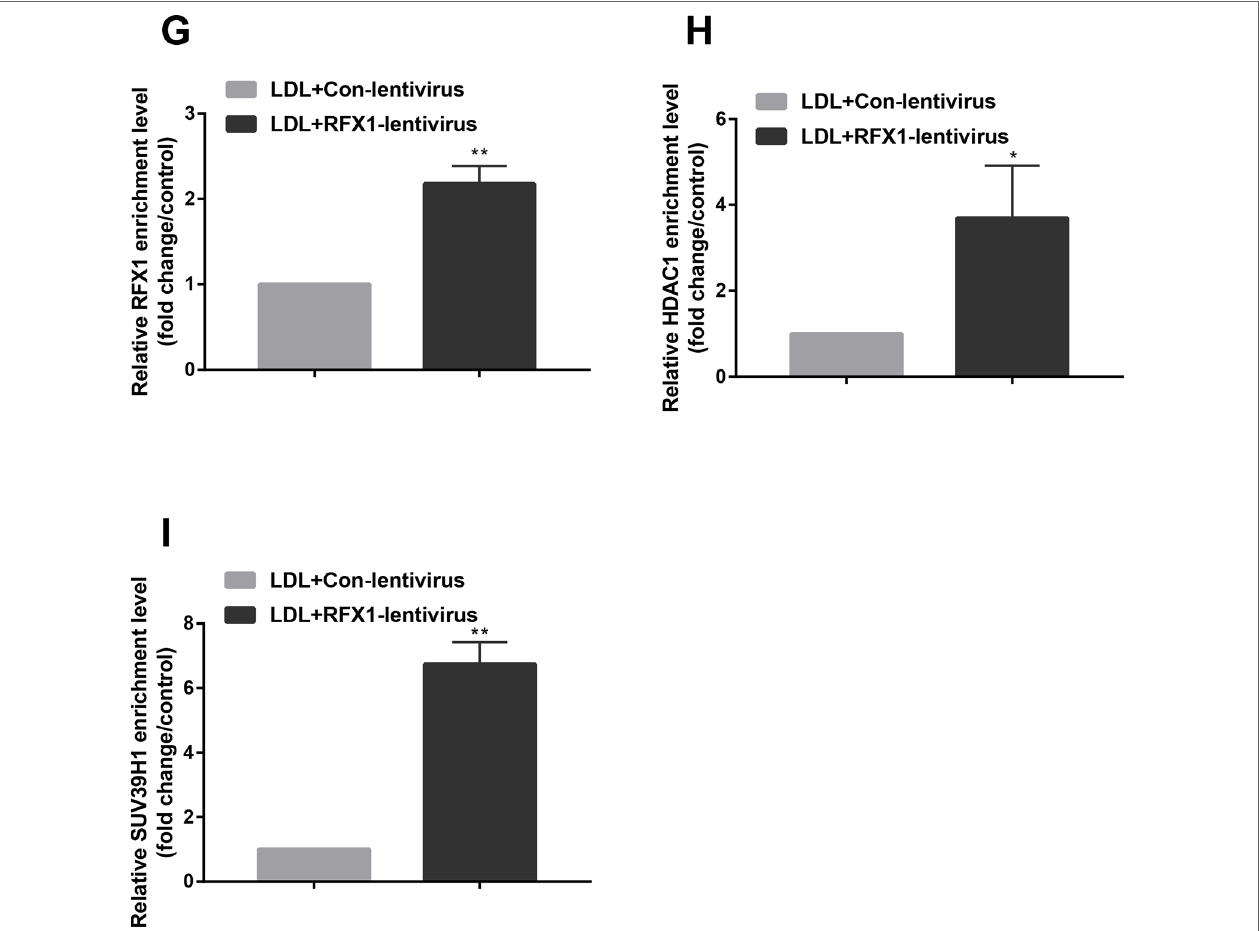
FigURE 5 | Overexpression of RFX1 reversed histone modifications in MCP1 promoter induced by LDL in CD14+ monocytes. (a) The RFX1 protein expression level was determined by western blotting in LDL-treated CD14+ monocytes transfected with RFX1-lentivirus or Cntl-lentivirus. (B – C) Relative MCP1 mRNA and protein expression levels were detected respectively by RT-qPCR and ELISA in LDL-treated CD14+ monocytes transfected with RFX1-lentivirus or Cntl-lentivirus. (D – F) The fold changes of relative H3 (D) and H4 (E) acetylation levels and H3K9 tri-methylation level (F) were detected by ChIP-qPCR in LDL-treated CD14+ monocytes. (g–i) The fold changes of relative recruitment levels of RFX1 (g) , HDAC1 (H) and HUV39H1 (i) in the promoter region of the MCP1 gene were determined by ChIP-qPCR in LDL-treated CD14+ monocytes. All values are the average of at least 3 biological replicates, and the data shown are the mean ± SEM. * P 0.05 and ** P 0.01 compared with the control